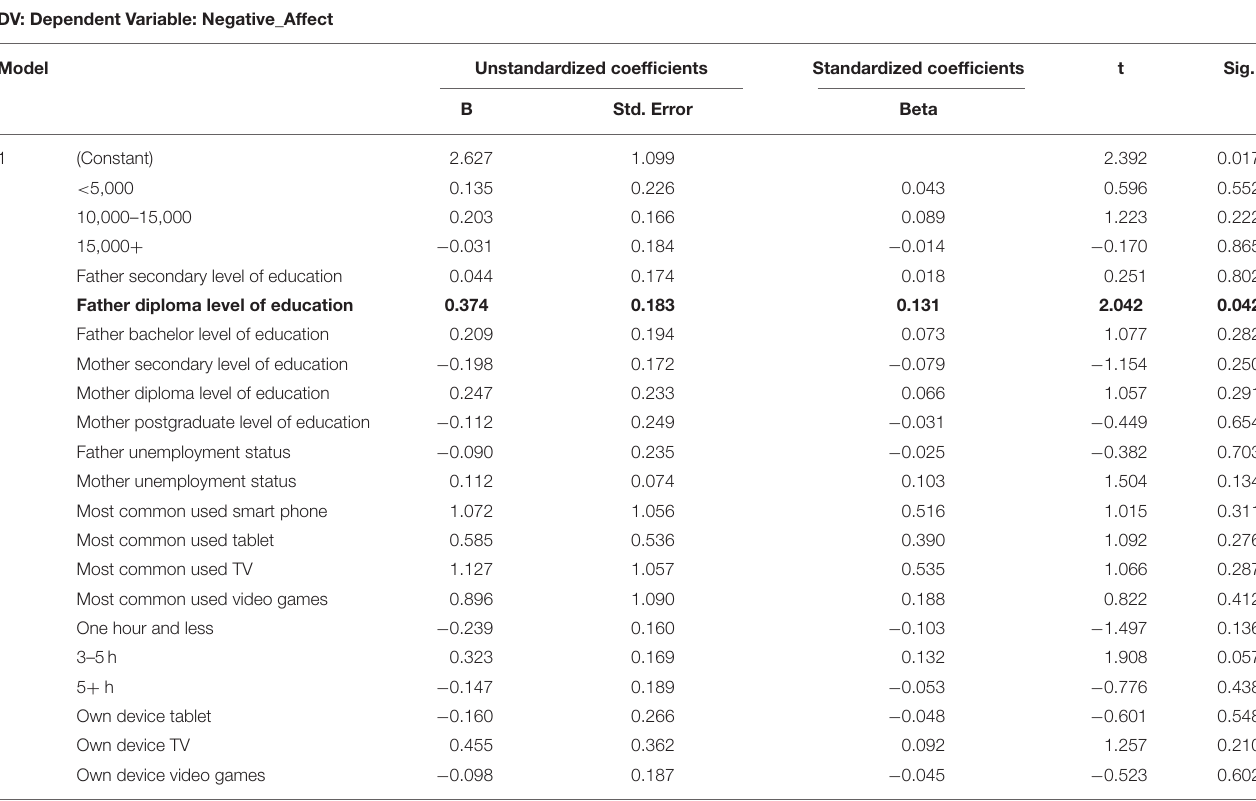
TABLE 6 | Regression coefficient table showing the strength of association between technology and demography variables and “Negative affect.” Coefficients